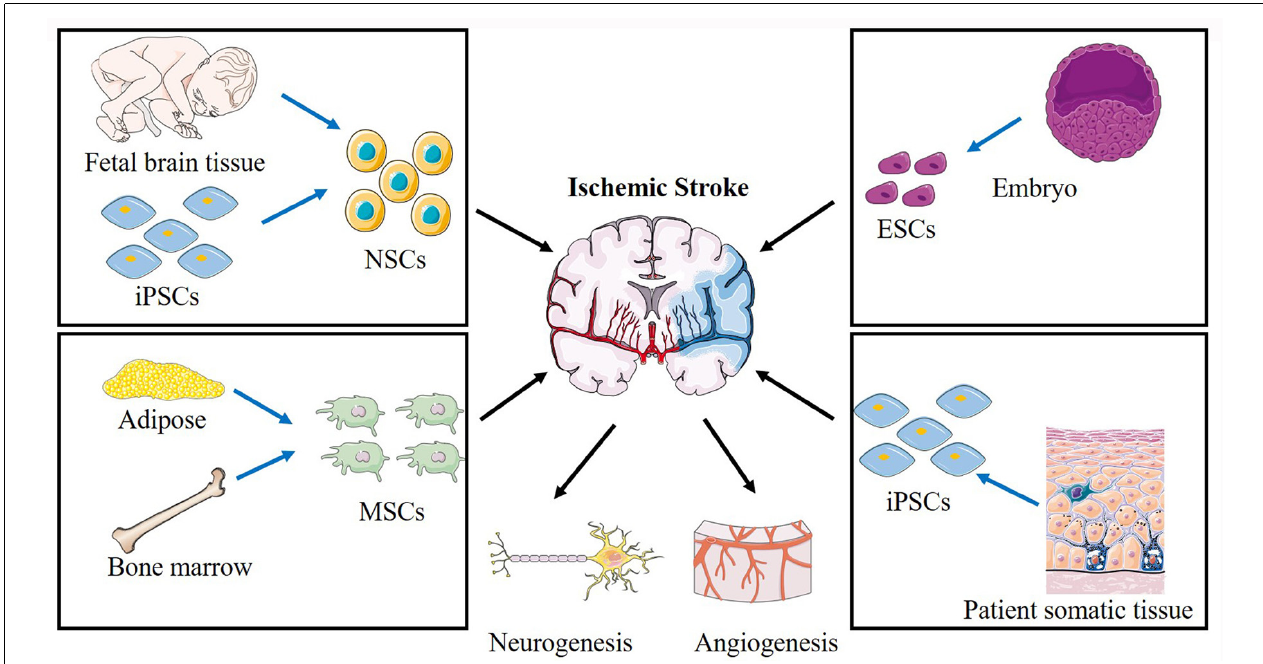
FIGURE 2 | Schematic of various stem cells applied in cerebral ischemic stroke and the proposed mechanisms. Different sources of NSCs, ESCs, MSCs, BMMCs, iPSCs are applied to treat ischemic stroke. NSCs, neural stem cells; ESCs, embryonic stem cells; MSCs, mesenchymal stem cells; iPSCs, induced pluripotent stem